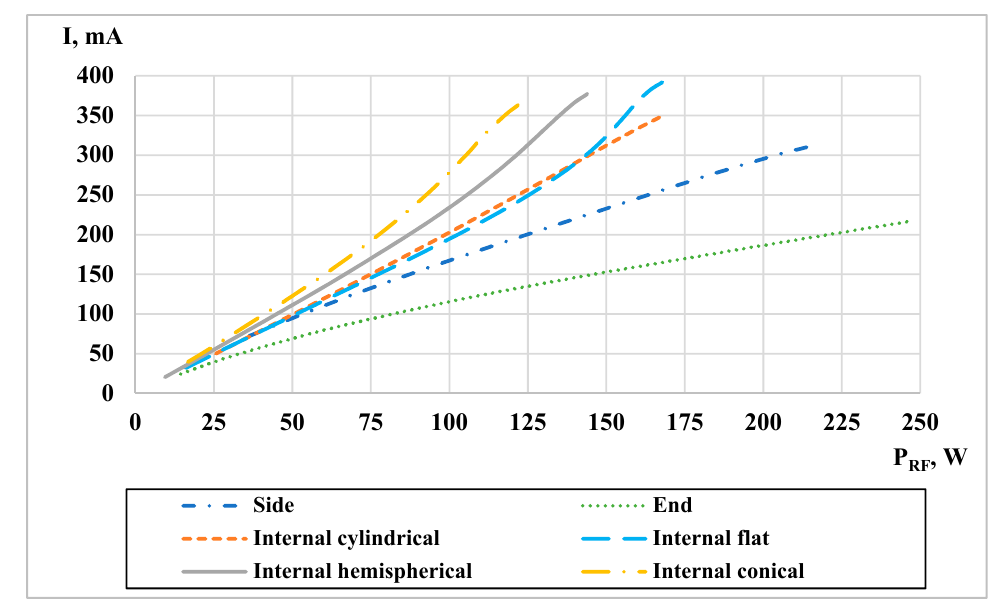
Figure 3 Dependences of the extracted ion current on the RF power input to the plasma at the xenon flow rate of 0.5 mg/s.